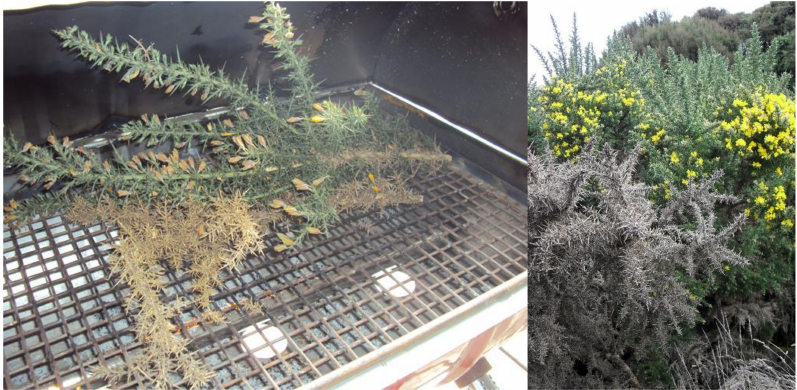
Figure 2. Showing placement of multiple samples on the grill (left), with dead material placed below the live material to be closer to the ignition source, and gorse in situ on Banks Peninsula, showing the dead material held underneath the live material, and the presence of horizontal shoots. (Photos J Dent and T